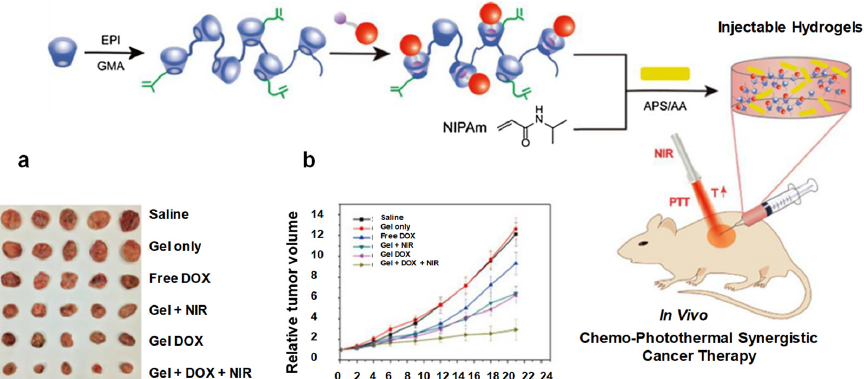
Figure 22. Schematic diagram showing hydrogel formation. ( a ) Photograph of excised tumors after mice were euthanized on the 21st day. ( b ) Changes in relative tumor volume. Reprinted with permission from ref. [36]. Copyright © 2020 Copyright © 2017, International Journal of Biological Macromolecules , Elsevier.